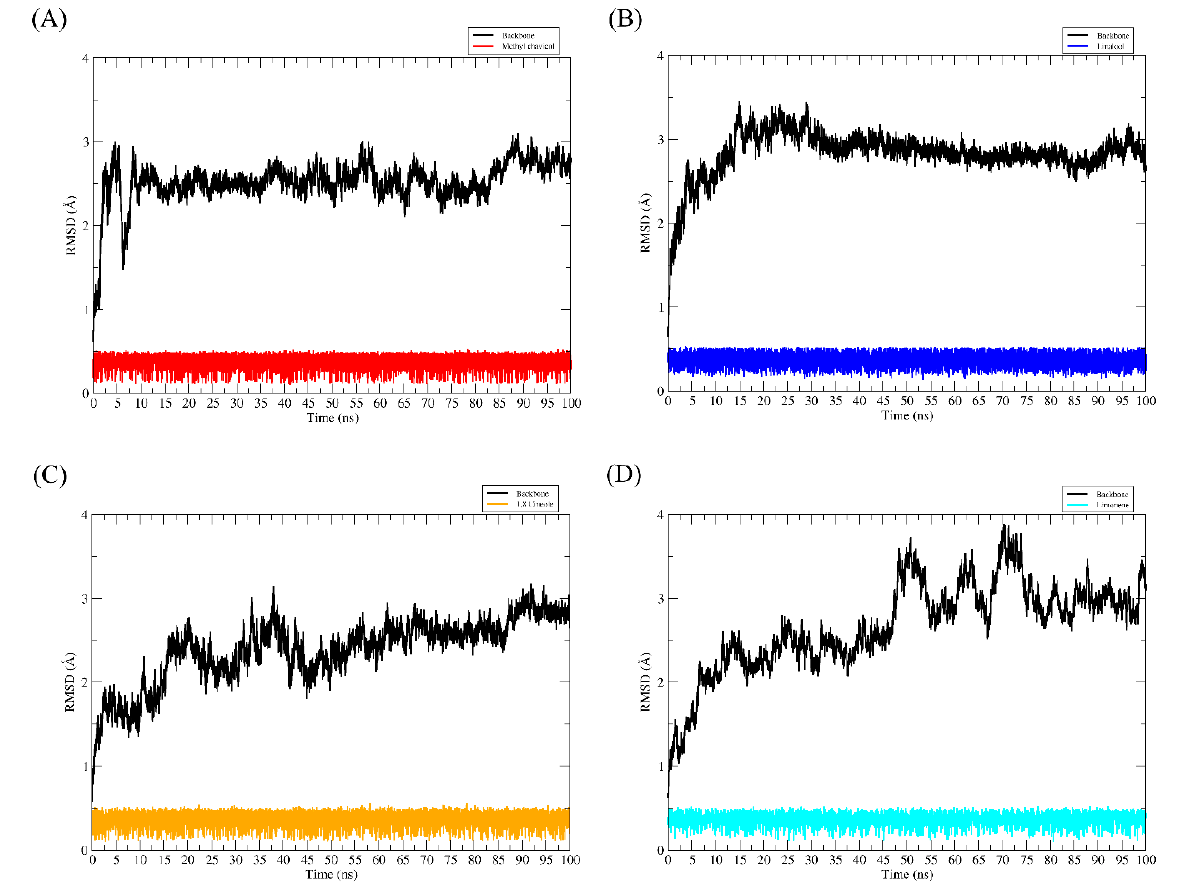
Figure 4. RMSD of AChE-ligand complexes ( A – D ).